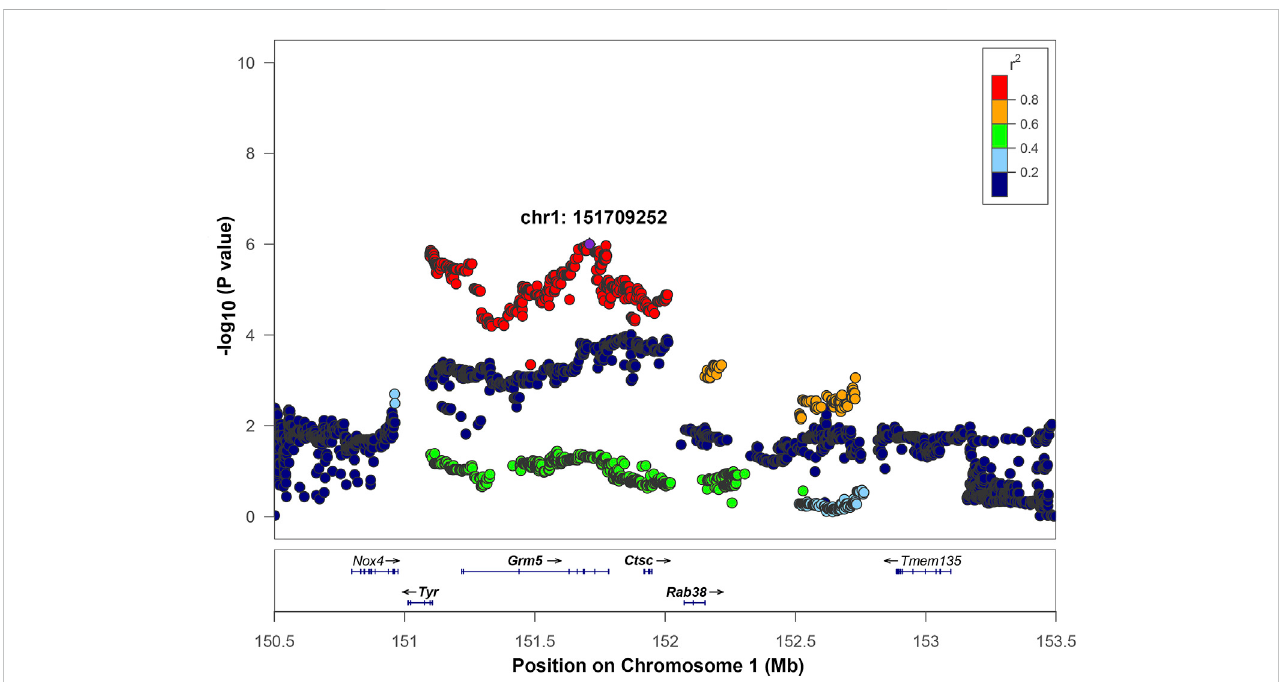
FIGURE 3 Regionalassociationplotfor QTLonchromosome1.The x -axis showsthechromosomal position.The SNPwith thelowest p -value( “ topSNP ” )isshown inpurple,anditschromosomalpositionisindicatedontheplot.Thecolorofthedotsindicatestheleveloflinkagedisequilibrium(LD)ofeachSNPwiththetop SNP,asmeasuredbycorrelation.Thebottompanelindicatesthegenesintheregion,asannotatedbytheNCBIReferenceSequenceDatabase.Genesthatare bolded ( Tyr , Grm5 , Ctsc , Rab38 ) are located in the interval of high LD of the top SNP based on a r 2 > 0.6